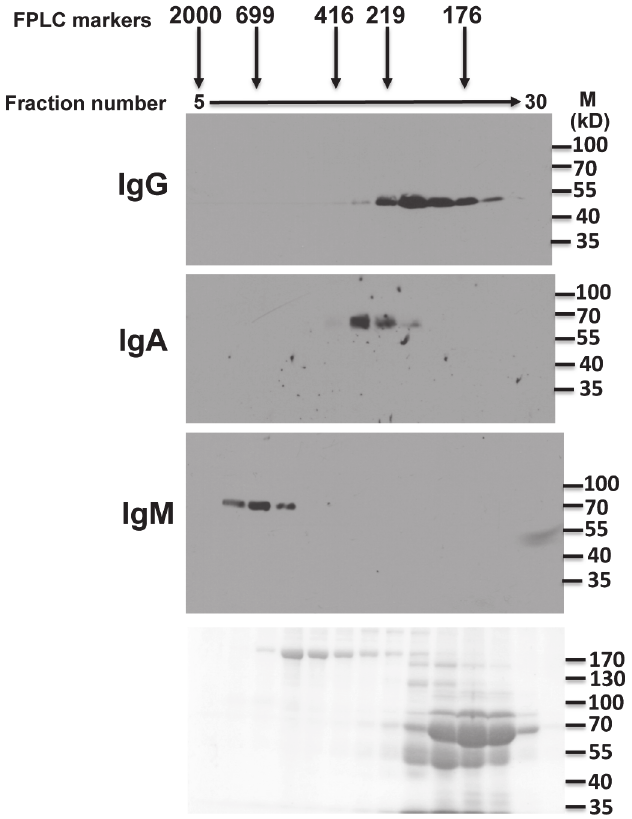
Fig 2. Immunoblot analysis of Asian elephant serum following fractionation by gel filtration. Liquid fractions eluting off from gel filtration of Asian elephant serum were resolved and analyzed by immunoblotting. Fraction numbers are labeled at the top and the approximate sizes of marker proteins are indicated. Three identical gels were then probed with isotype specific antisera or monoclonal antibody (anti- IgG) as indicated to the left of each blot. The bottom panel is a coomassie stained gel identical to the gels used for the Westerns above. Molecular weight markers for the blots are shown on the right of each panel.